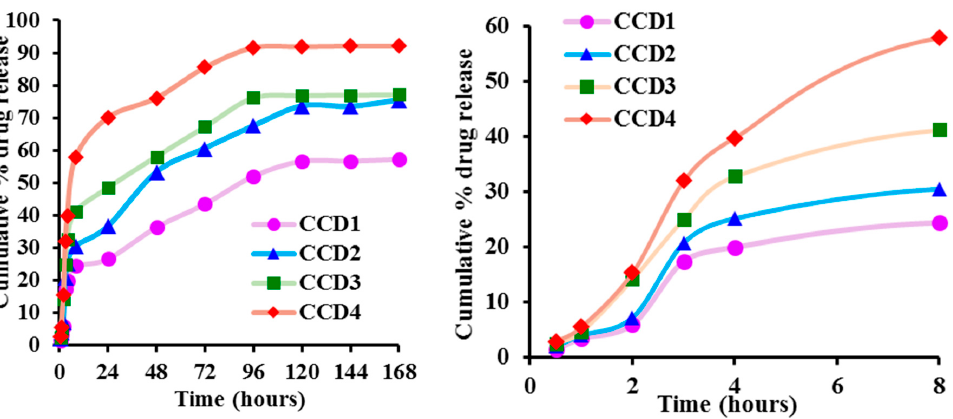
Figure 6. UV-VIS spectrum for CC4 and CCD4 samples dissolved in PBS (1/9 v / v ).